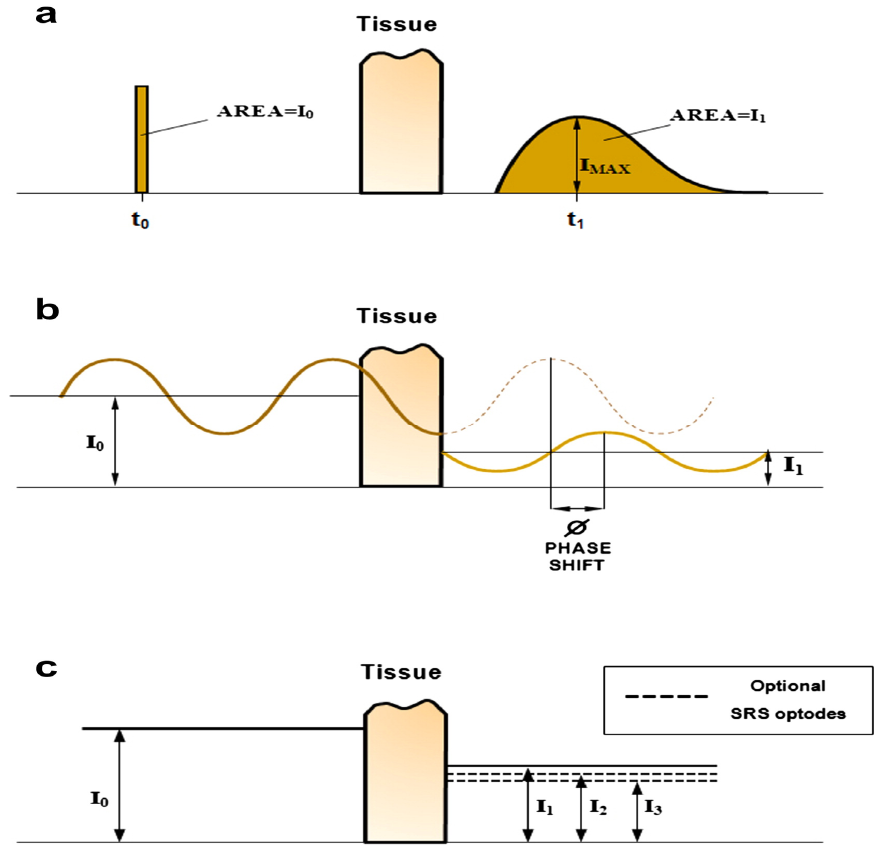
Figure 1. Visual representation of the case ( c ) continuous wave, case ( b ) frequency domain, and case ( a ) (adapted from Ref. [6]).